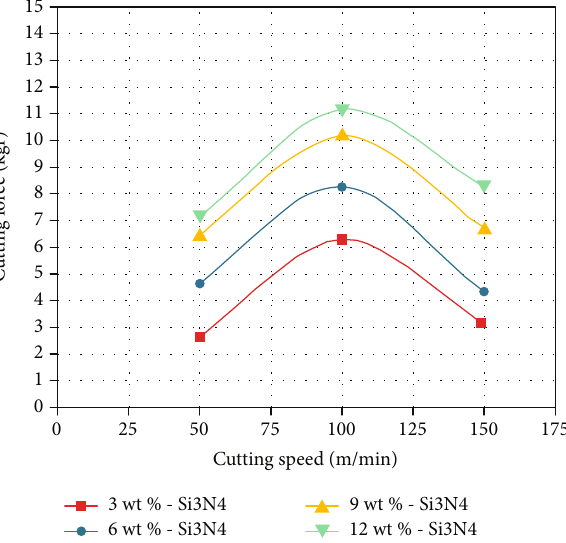
Figure 6: Depth of cut vs. cutting force (cutting speed 100 m/min).